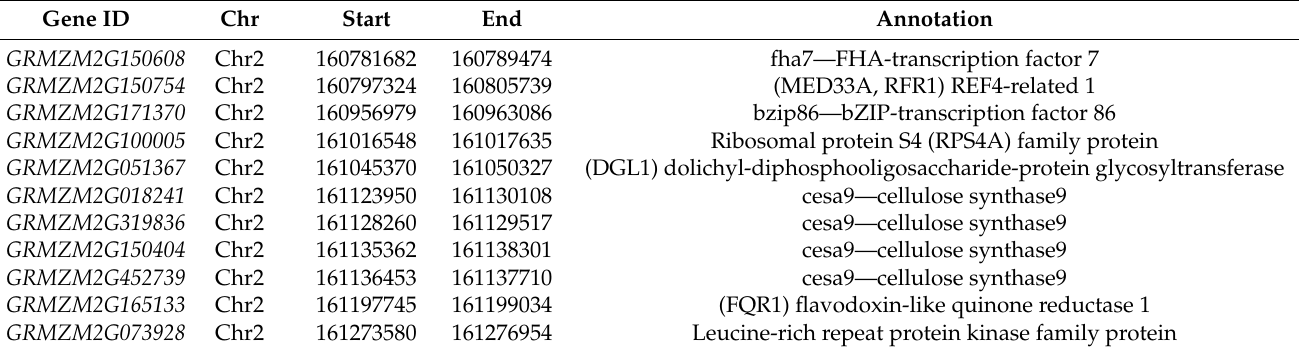
Among all overlapped SNPs, only 10 SNPs were found in the exon of the candidate genes. There were three SNPs located at GRMZM2G051367 and six SNPs located at the exon of GRMZM2G073928 (Table 4). Among them, three SNPs, chr2.S_160782359